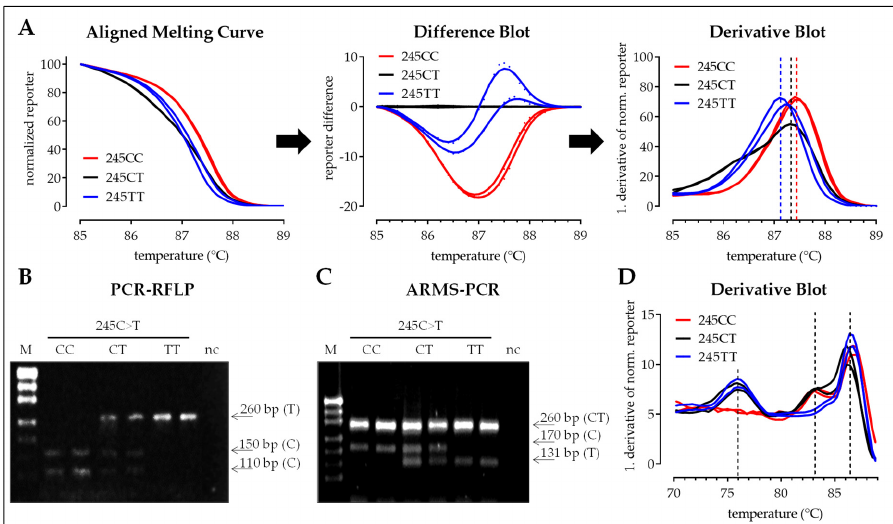
Figure 7. Detection of SNP 245C > T with four di ff erent methods: HRM-PCR, PCR-RFLP, conventional, and one-step ARMS-PCR. ( A ) High resolution melting curve analysis following SNP flanking PCR can be done using the aligned melting curve (normalized reporter), the resulting di ff erence blot (di ff erence of the normalized reporter with heterozygous samples as reference), or derivative blot (1. derivative of the normalized reporter). ( B ) Representative band pattern following enzymatic digestion of the SNP flanking PCR products with SsiI also known as AciI (PCR-RFLP). ( C ) Representative band pattern of the conventional ARMS-PCR. ( D ) Melting curve analysis following one-step ARMS-PCR is performed with the derivative blot (1. derivative of the reporter). Presented data for the three methods were obtained from the same six